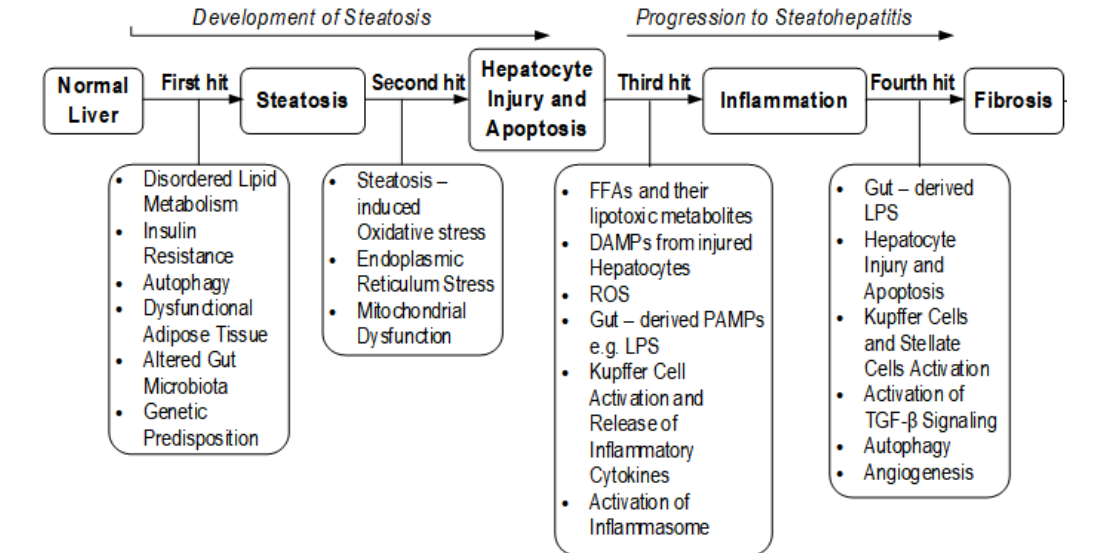
Figure 1. Factors contributing to the hits in NAFLD. FFA, free fatty acids; DAMP, damage-associated molecular pattern; PAMP, pathogen-associated molecular pattern; LPS, lipopolysaccharide; TGF- β , tumor growth factor-beta.